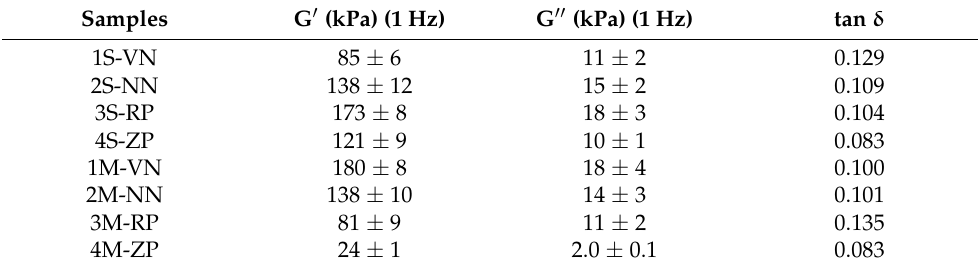
Table 1. G (cid:48) , G (cid:48)(cid:48) and tan δ (i.e., G (cid:48)(cid:48) /G (cid:48) ) parameters from rheological analysis on fresh slices of peaches and nectarine